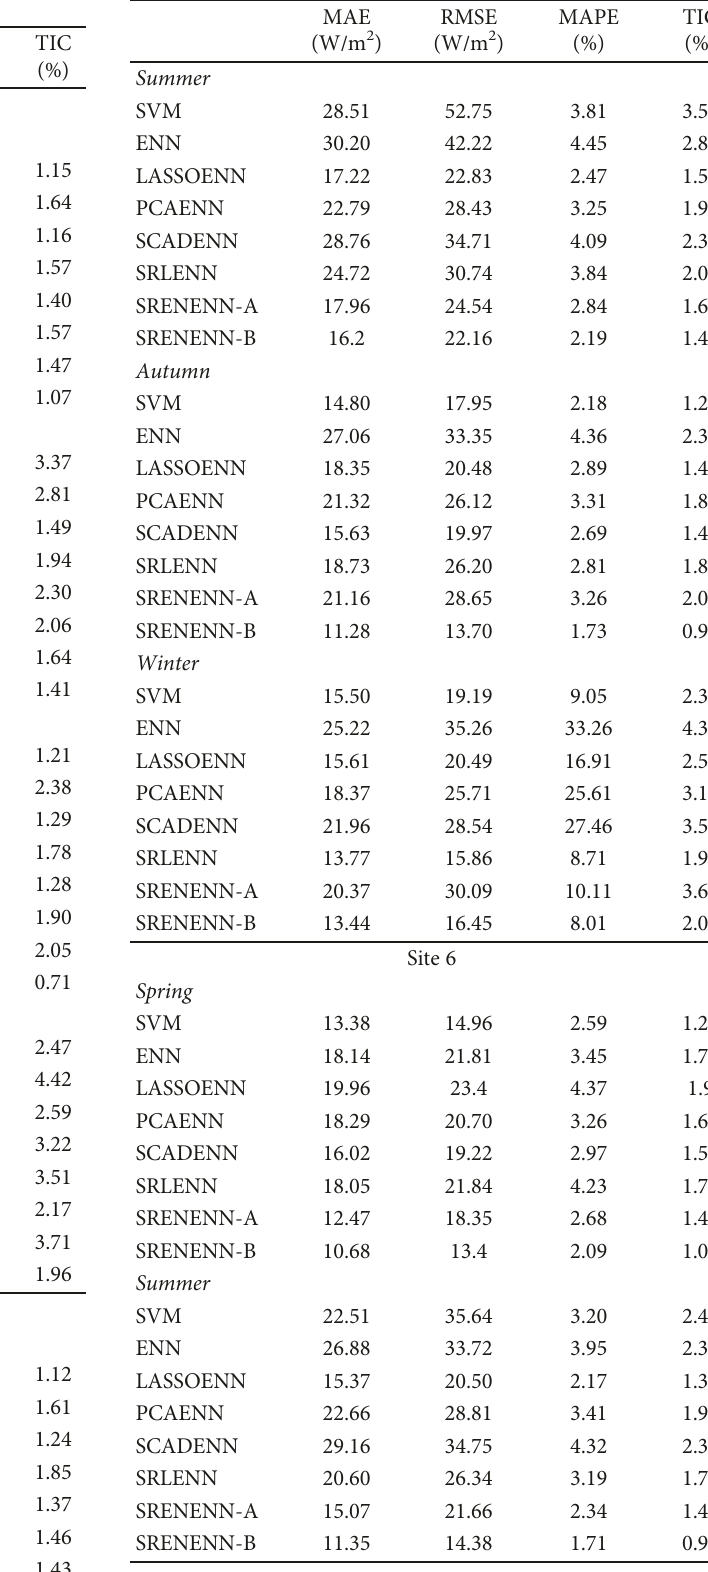
Table 6: Mean forecasting errors of forecasting models for each season at Site 4, Site 5, and Site